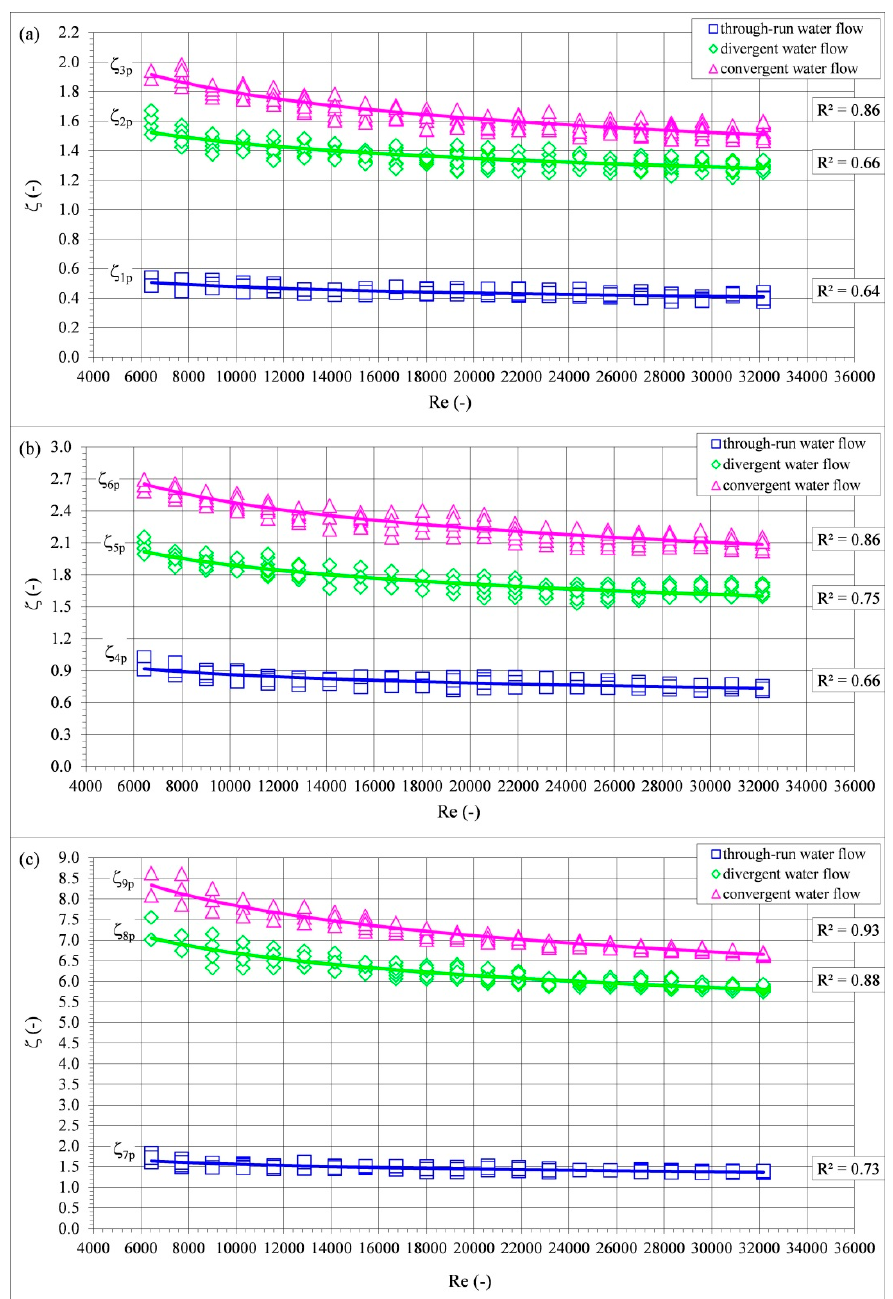
Figure 5. Dependence between the mean pressure difference Δ p in the screwed joints and polypropylene pipe sections and the water flow rate q.